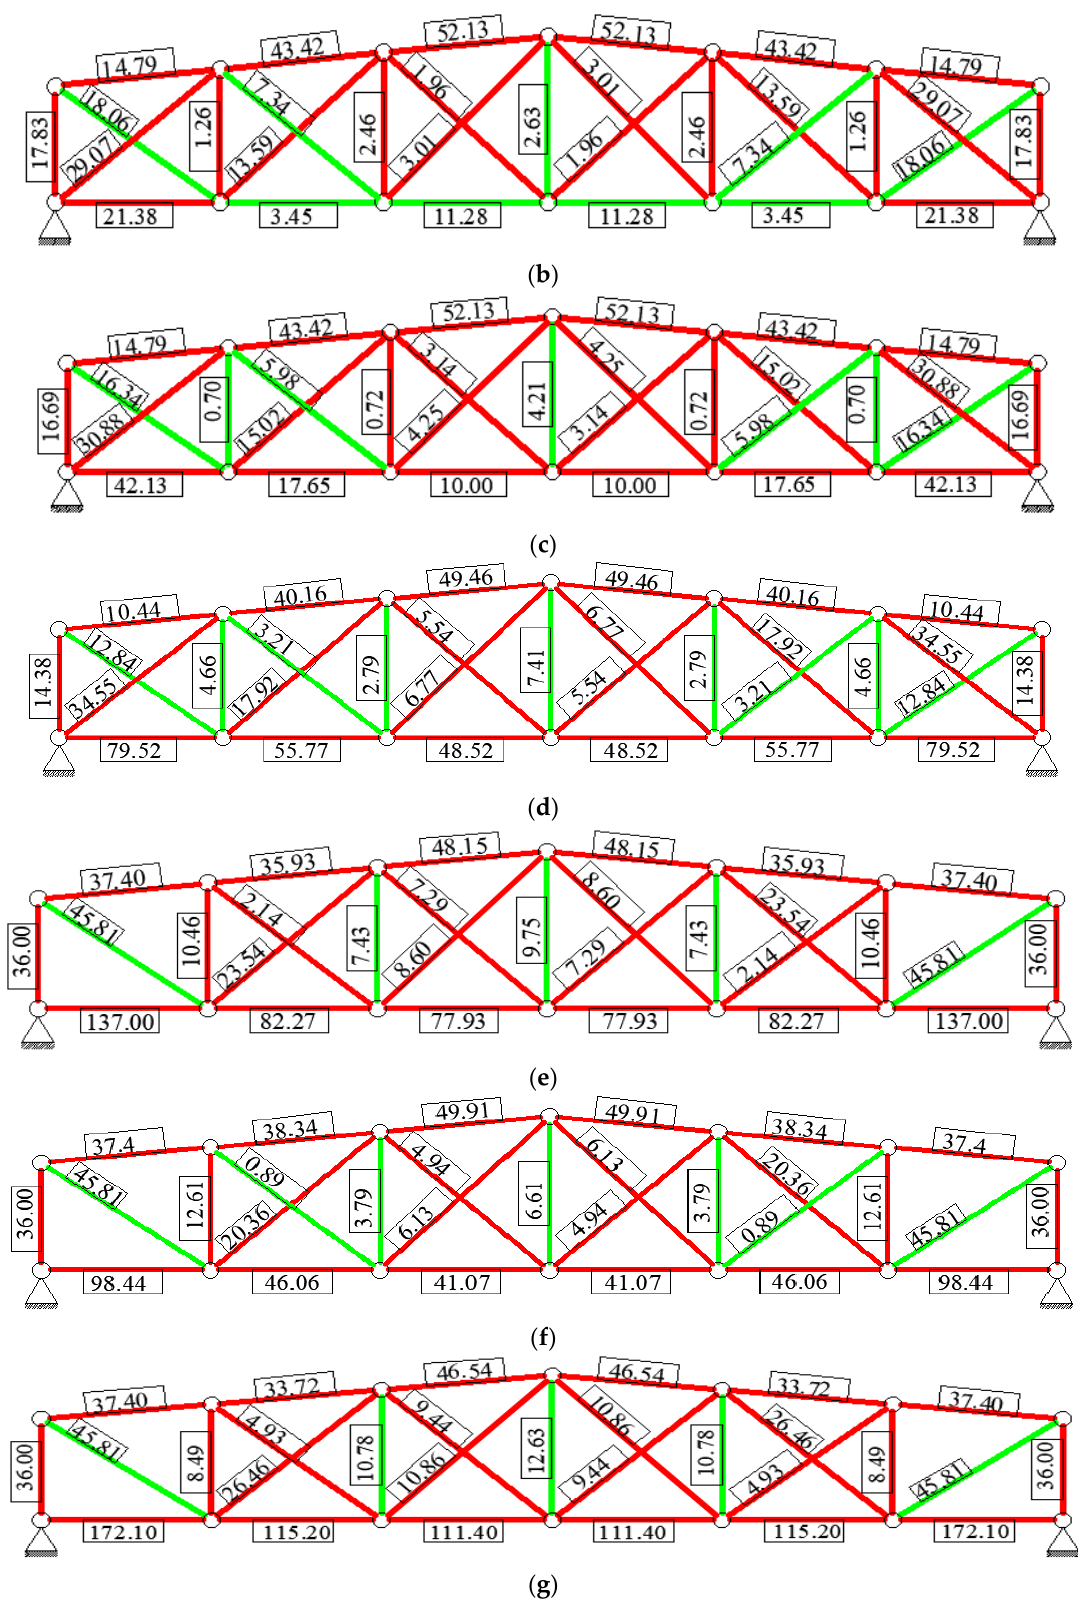
Figure A2. Cross-sectional forces of truss “B” in the passing minutes of a fire: ( a ) t fi = 0 min, 1 min; ( b ) t fi = 2 min; ( c ) t fi = 3 min; ( d ) t fi = 4.1 min (246 s); ( e ) t fi = 4.12 min (247 s); ( f ) t fi = 5min; and ( g ) t fi = 5.73 min (344 s).